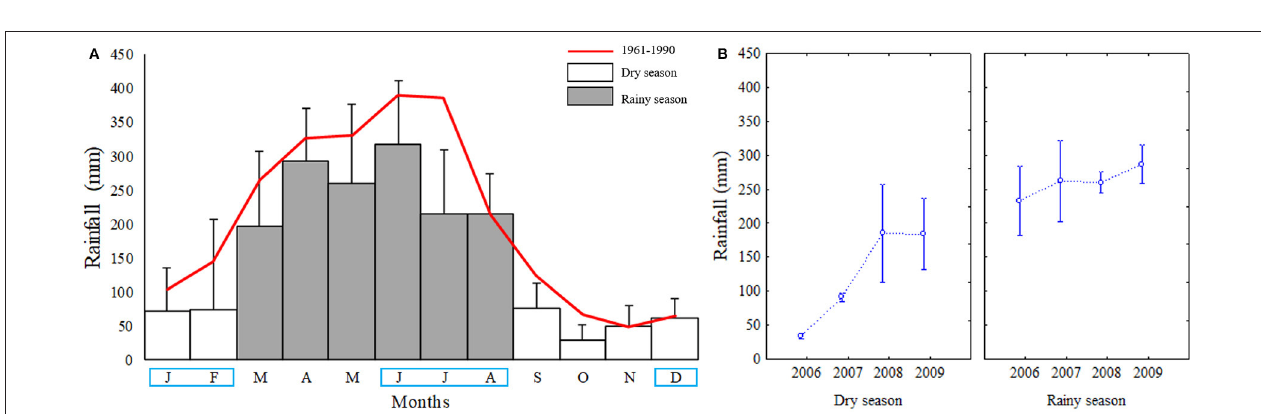
FIGURE 1 | Location of Goiana River estuary, showing upper estuary, middle estuary, and lower estuary along the main channel. Source: Google maps, adapted.